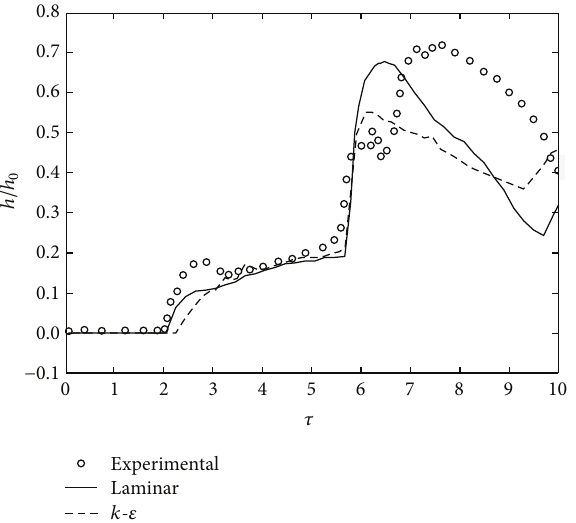
Figure 5: Comparison of the water front.